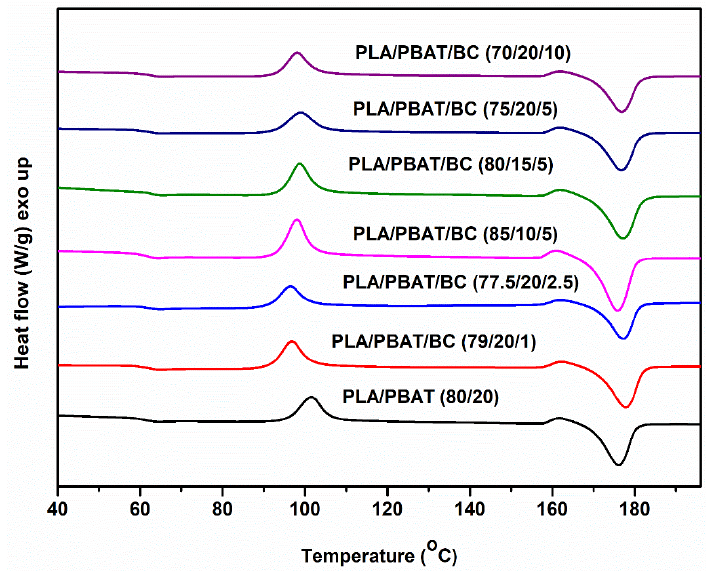
Figure 4. DSC of PLA/PBAT/BC composites. Table 2. Thermal properties of the PLA/PBAT/BC